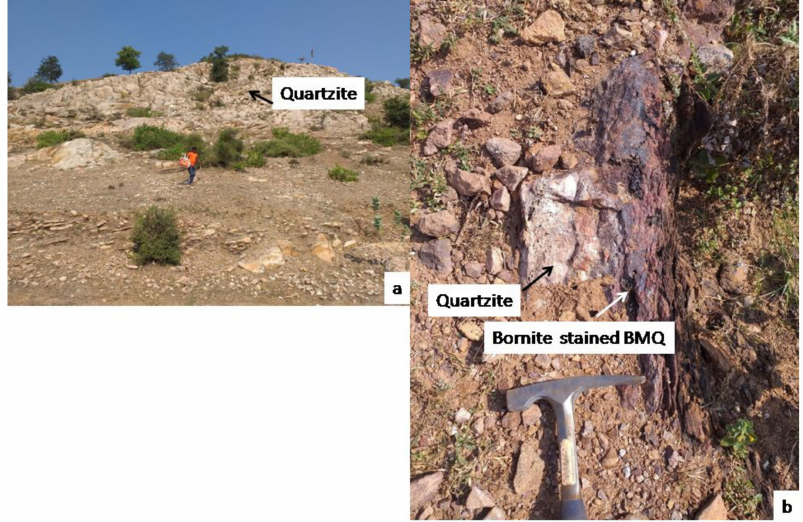
Figure 18. ( a ) The barrensurface exposures of quartzite hill trending NE-SW, near Balykhera area, Bhilwara district, Rajasthan. ( b ) The contact between sheared magnetite rich quartzite and BMQ shows surface indications of mineralization near Pur village near Balykhera, Bhilwara district,